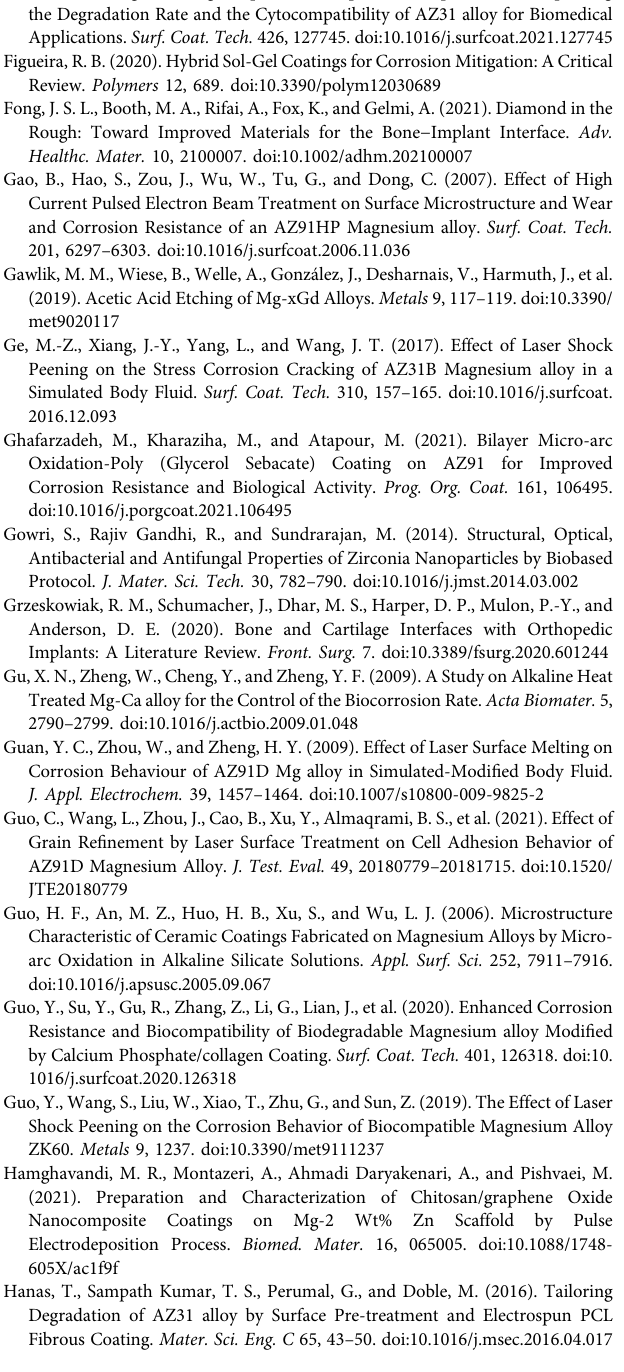
Figueira,R.B.(2020).HybridSol-GelCoatingsforCorrosionMitigation:ACritical Review. Polymers 12, 689.